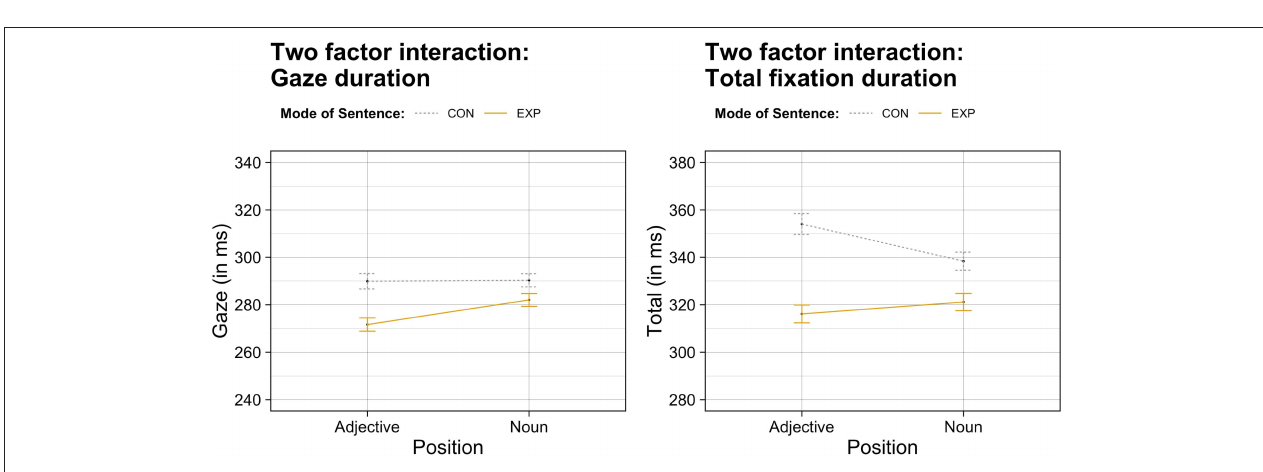
Frontiers in Communication |